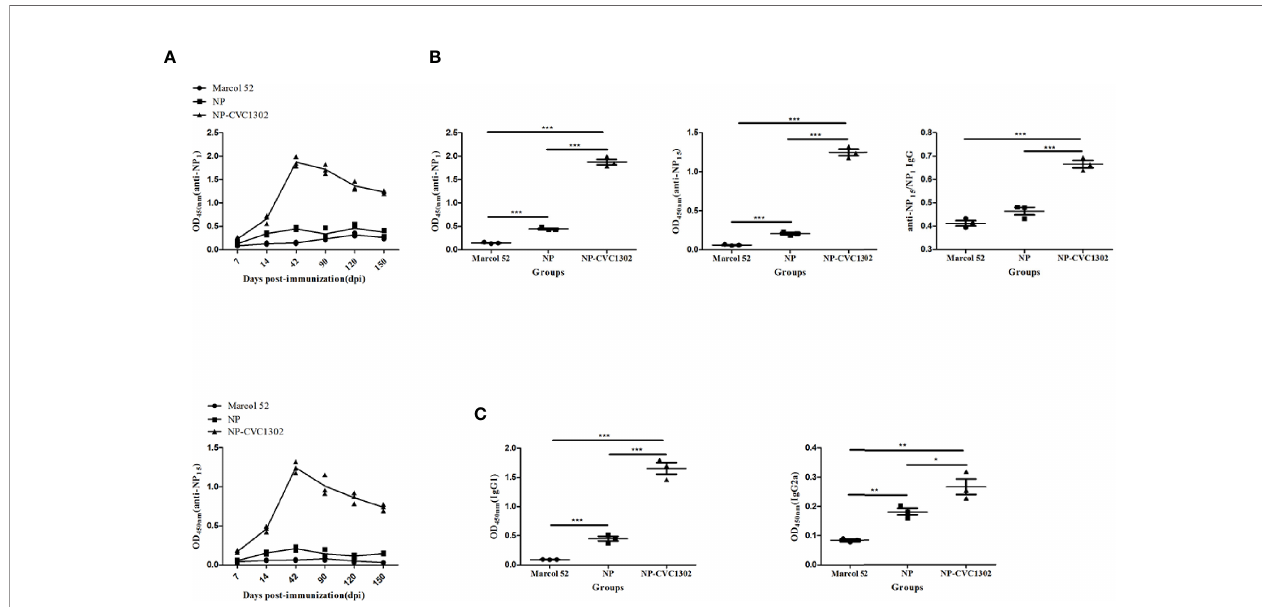
FIGURE 3 | Effect of CVC1302 on af fi nity maturation. (A) Kinetics of diverse-af fi nity anti- NP IgG (anti-NP15, upper ) and high-af fi nity anti-NP IgG (anti- NP1, lower ) antibody levels following immunization with Marcol 52, NP, or NP-CVC1302. (B) Levels of diverse-af fi nity anti-NP IgG ( left ), high-af fi nity anti- NP IgG ( center ), and af fi nity maturation of anti-NP IgG (ratio of anti-NP1 to anti-NP15 IgG, right ) as measured by ELISA at 42 dpi. (C) Total anti-NP IgG1 (left) and IgG2a (right) levels were measured by ELISA at 42 dpi as in (A) . Values show the mean ± SEMs of 7 mice per treatment group. * P < 0.05, ** P < 0.01, *** P < 0.001.